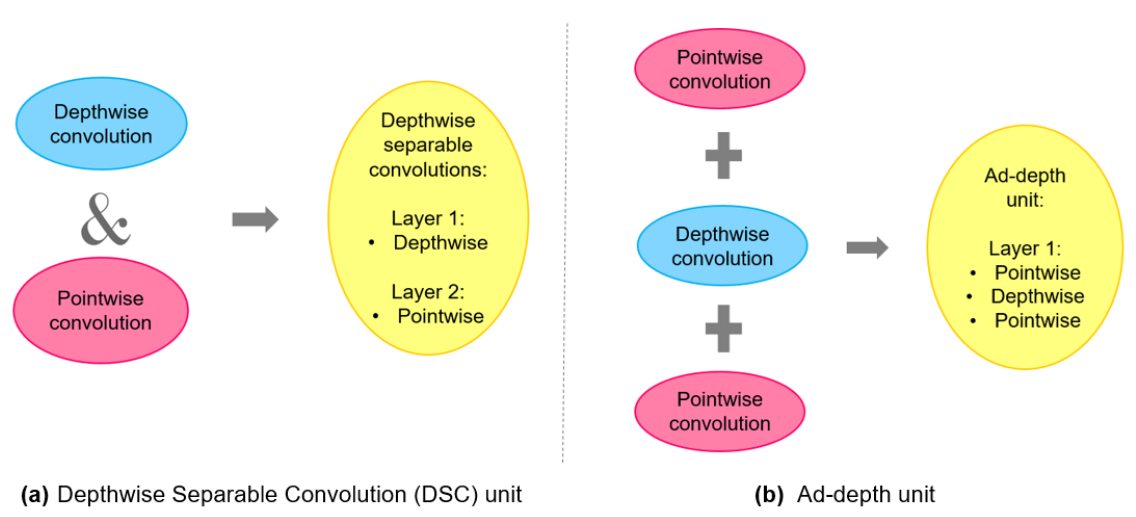
Figure 5. Comparison between the standard DSC unit and the Ad-depth